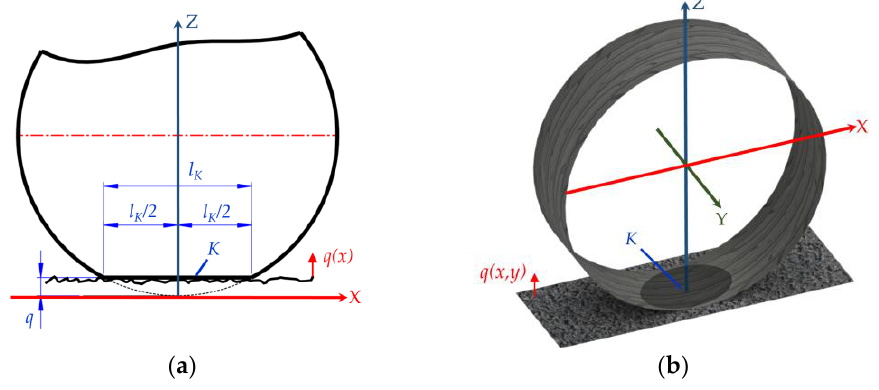
Figure 7. Tire models: ( a ) flexible ring; ( b ) flexible band.